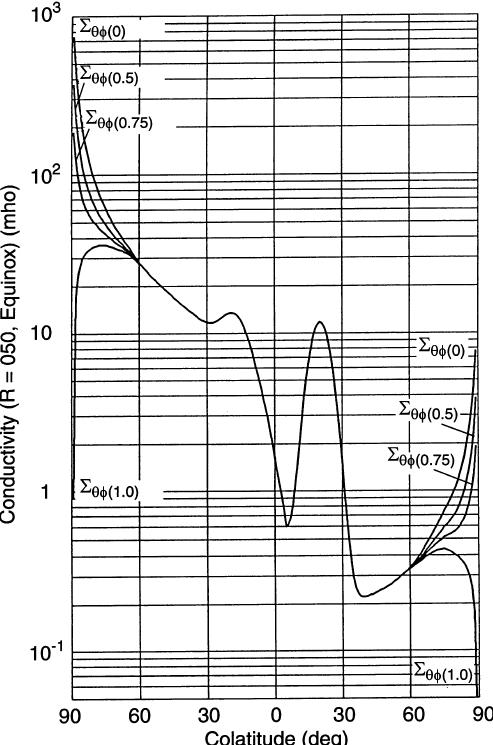
Fig. 2. Noon-midnight profiles of S with maximum reduction rates hu of 0% ( S ), 50% ( S ), 75% ( S ) and 100% ( S ) for hu (0.0) hu (0.5) hu (0.75) hu (1.0) the E contribution in the longitudinal direction. The IRI parameters z and the plot style are same as those for